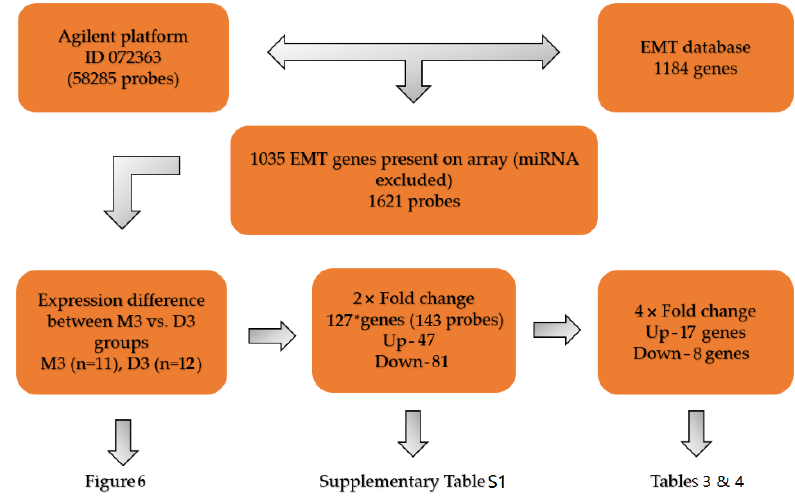
Figure 5. A flow-chart depicting the workflow of the procedure for selecting genes from the EMT database and evaluating the di ff erences in mRNA expression in M3 and D3 tumors. * One gene with opposite regulation of its two transcripts was excluded. Sample UM56 (Class 2 expression profile, monosomy1, D3) was excluded from the statistical analysis.